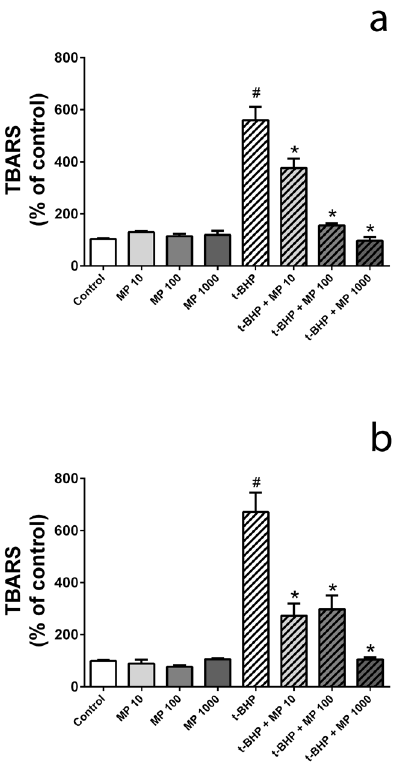
Figure 2 – Effect of M. pulegium AE ( a ) and EE ( b ) on basal and/or t-BHP-induced TBARS production. * indicates statistical difference (p<0.05) from respective control ( i.e . from basal or from t-BHP). # indicates statistical difference (P<0.05) from basal; n=5; MP = Mentha pulegium